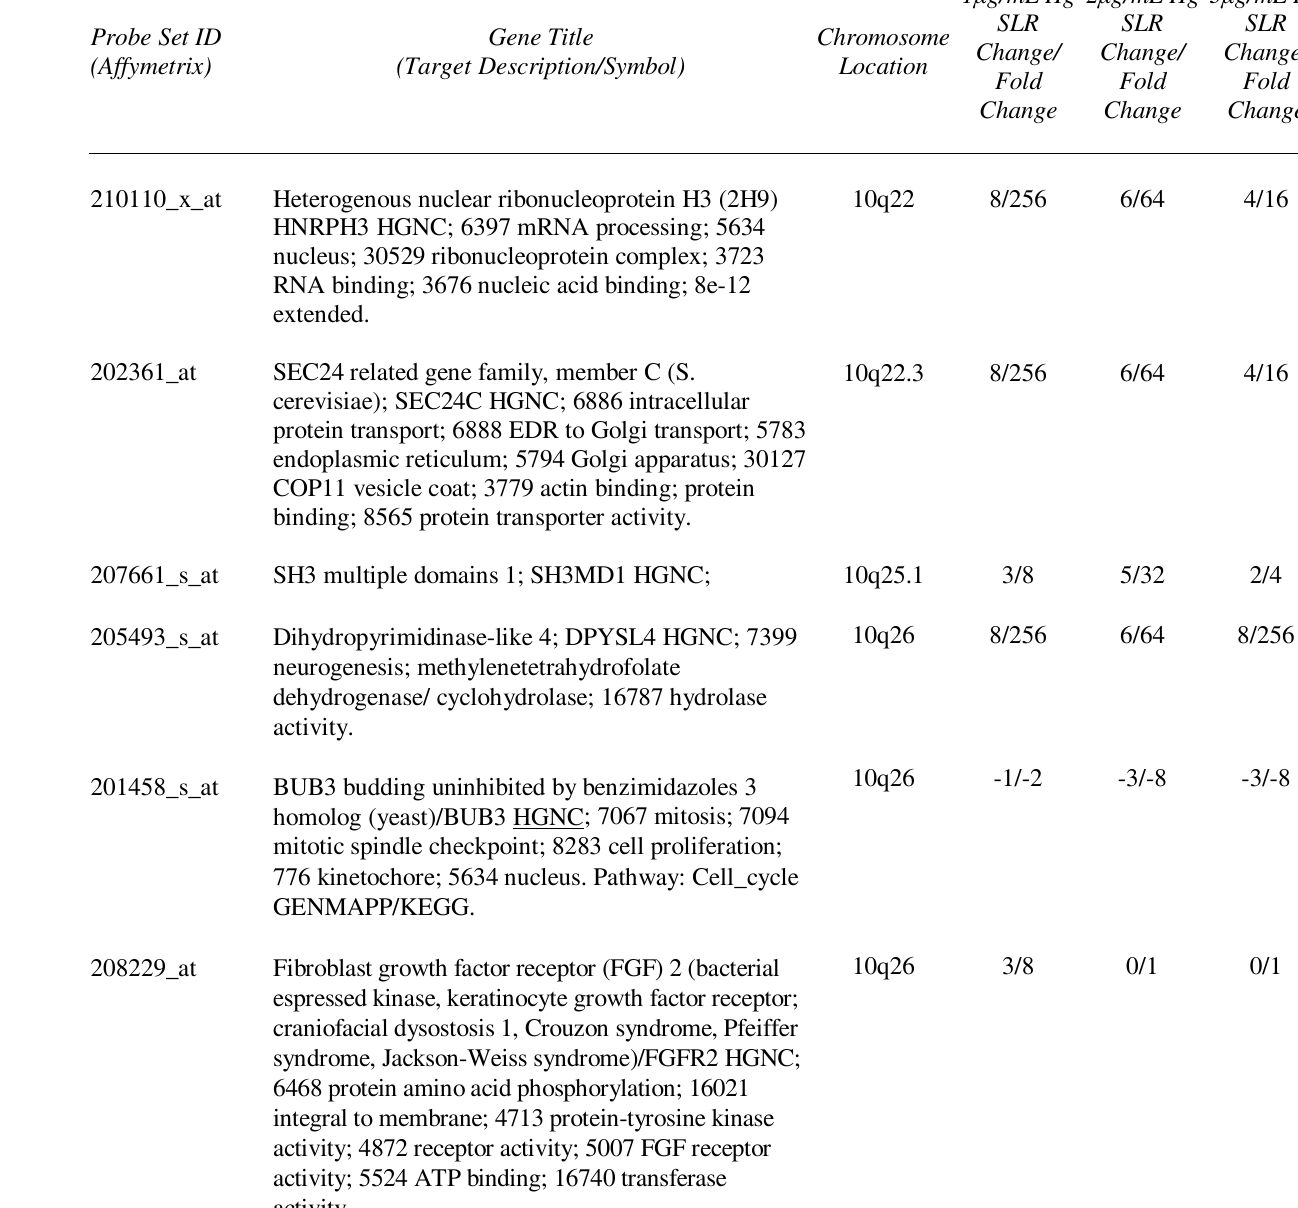
Table 1 contd.: Sample genes affected by mercury. Probe Set